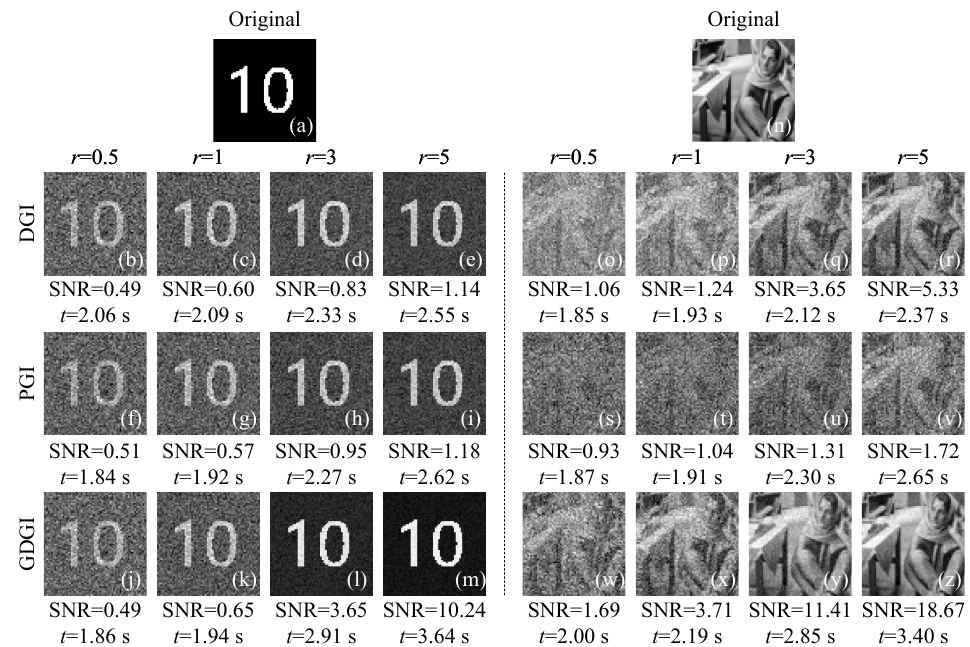
Figure 5. Simulation results of another two images “03” and “04” (all of 64 × 64 pixels) using the DGI, pseudo-inverse GI (PGI) and GDGI algorithms with r = 0.5,1,3,5 sampling rates. ( a , n ) are the original images, ( b – e ) and ( o – r ), ( f – i ) and ( s – v ), ( j – m ) and ( w – z ) are the images recovered by the DGI, PGI and GDGI,